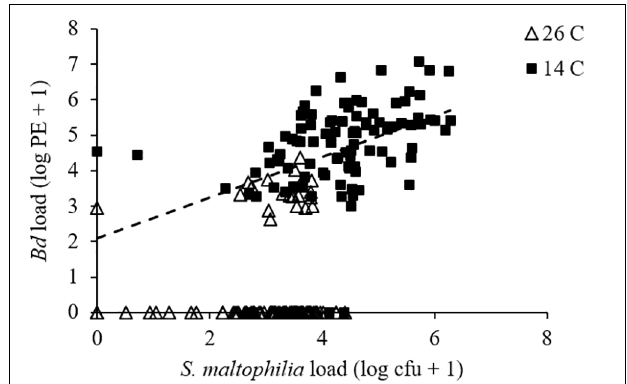
FIGURE 2 | Relationship between Bd load, measured as log 10 of PEs and S. maltophilia load, measured as log 10 of colony forming units (cfus) for Bd -exposed frogs. Line is the least-squares line of best fit ( y = 0.5722 x + 2.0977; R 2 = 0.171) for frogs at 14 ◦ C. The relationship was non-significant at 26 ◦